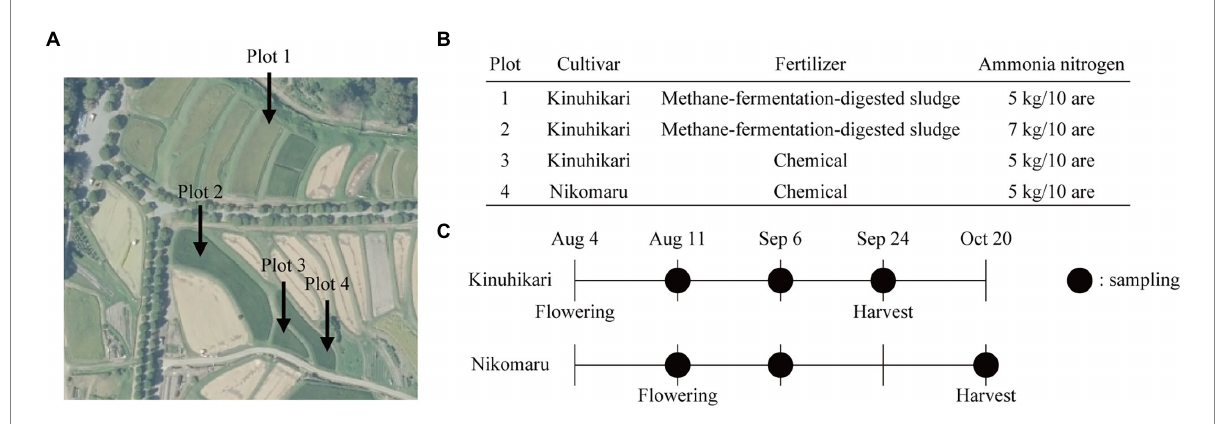
FIGURE 1 Field experiment design and sample collection. (A) The aerial photograph of the rice paddies used in this study. The photograph was taken by the Geospatial Information Authority of Japan (https://maps.gsi.go.jp/vector/#17/35.052689/135.801694/&ls=photo&disp=1&d=l). (B) Design of the field experiment. Each plot differs in types of cultivars, fertilizers, or the amounts of ammonia nitrogen. (C) Sampling time points of bulk and rhizosphere soils. Black-filled circles indicate sampling time points.